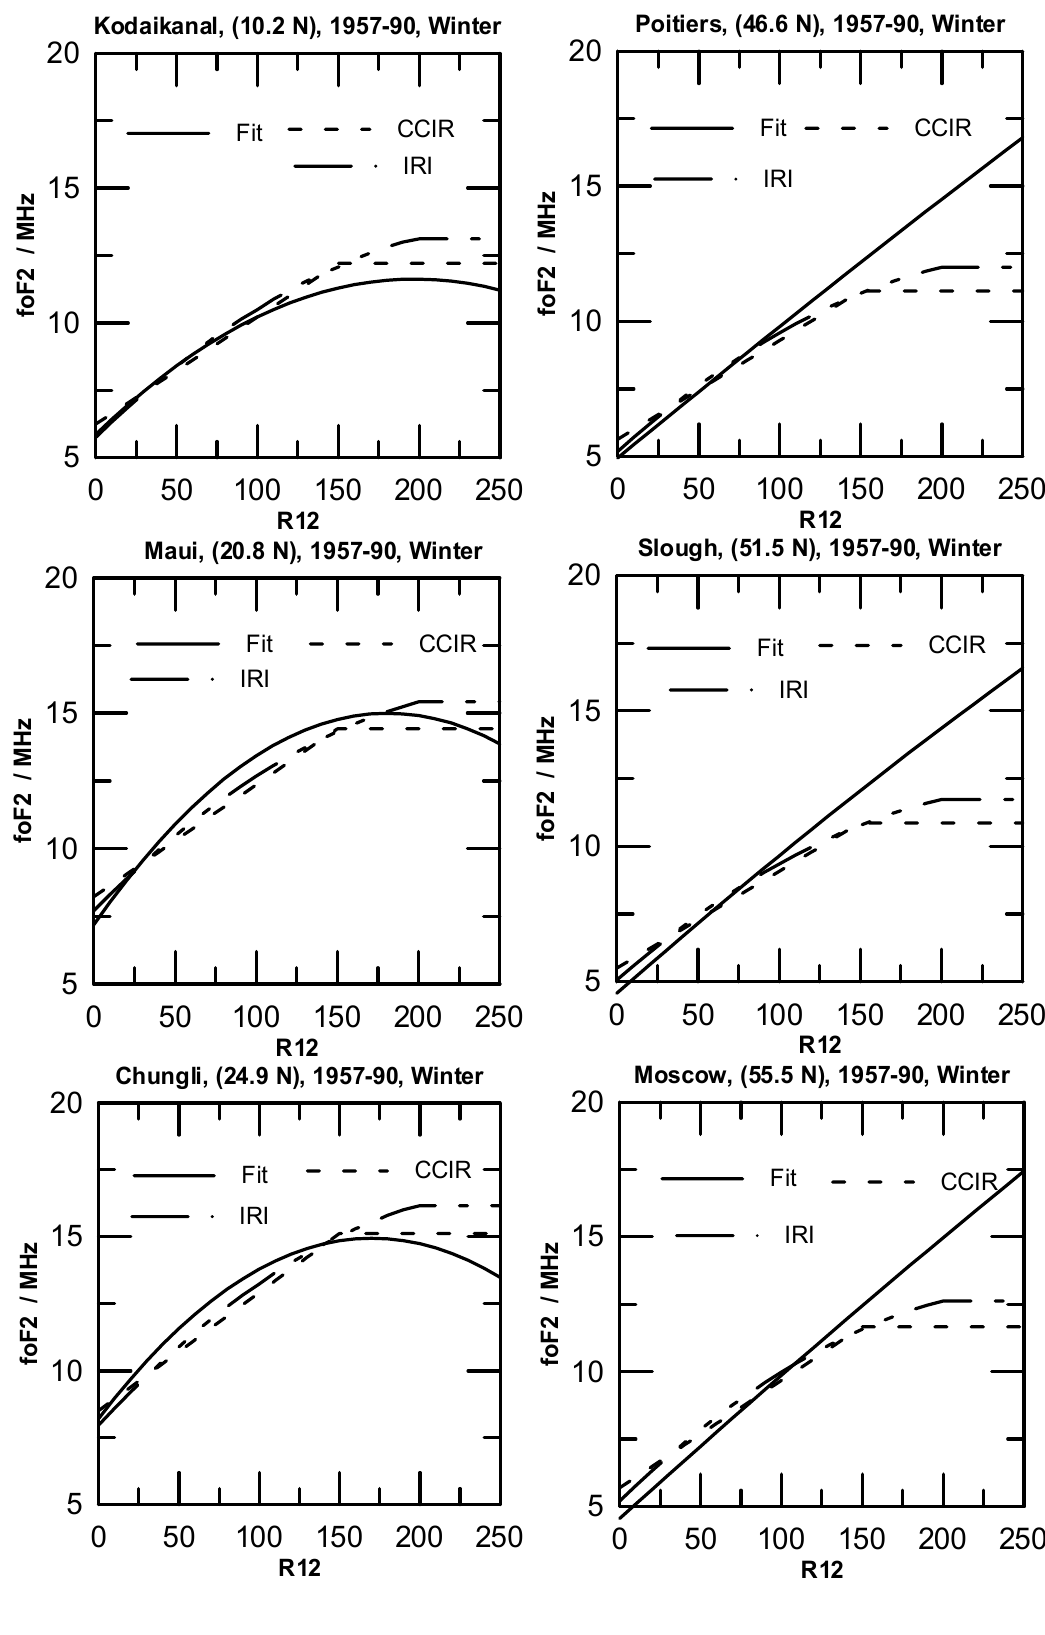
Fig. 5. Same as Fig. 4 but for